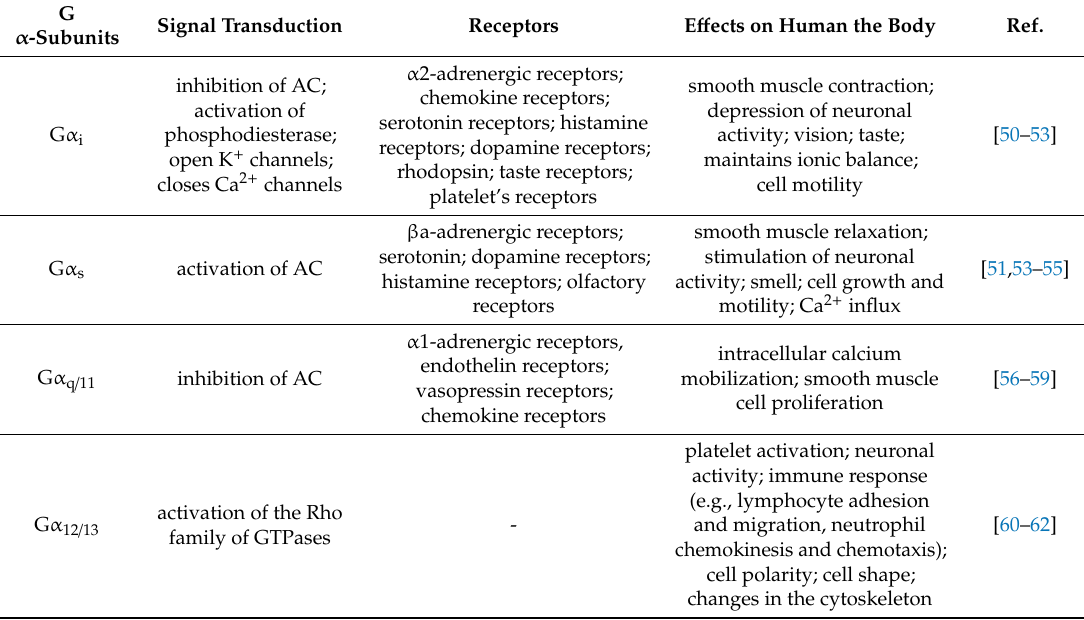
Table 1. Types of G α -protein and potential e ff ects on the human